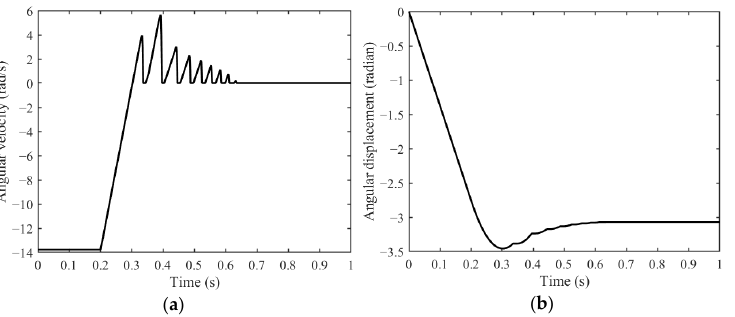
Figure 12. Dynamic features of output shaft under reverse load. ( a ) Angular velocity. ( b ) Angular displacement.